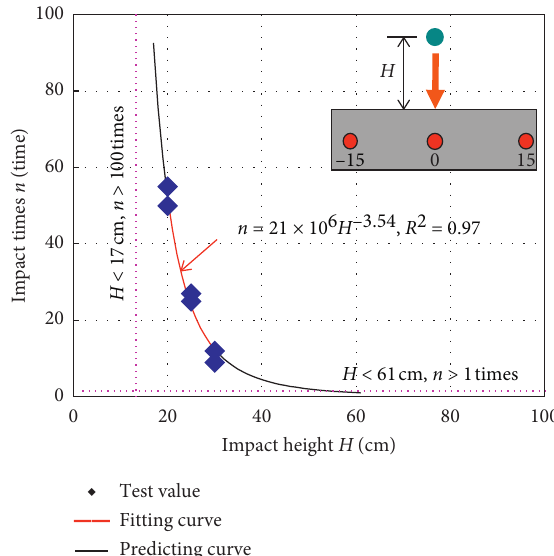
Figure 10: Relationship between the impact height and the limit impact times of the C50 concrete